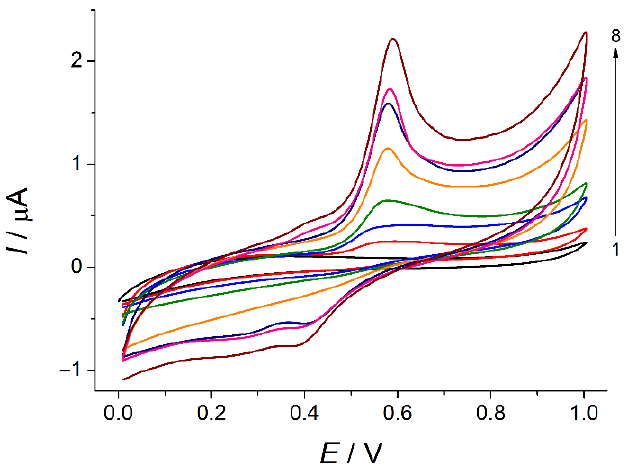
Figure 8. Cyclic voltammograms of 50 µM indigo carmine at the SeO 2 –CPB/GCE at the various potential scan rates: 5 (curve 2), 10 (3), 25 (4), 50 (5), 75 (6), 100 (7), and 150 (8) mV s − 1 in phosphate buffer pH 5.0 (curve 1).